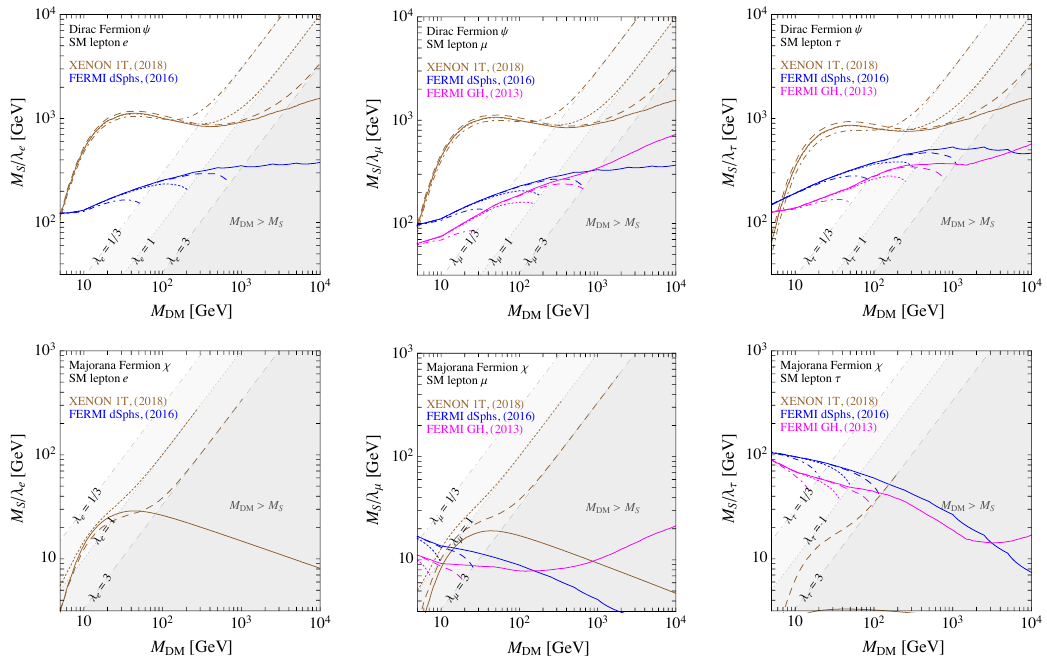
Figure 7 . Constraints on the UV models for Dirac (upper panels) and Majorana DM (lower panels), for couplings to e; (cid:22) and (cid:28) . In grey is shown the excluded region of parameter space where M DM > m S , which depends on (cid:21) i due to the choice of the y-axis. Regions below the brown lines are excluded by DD constraints from XENON1T, while the blue (magenta) lines denote the bounds from ID, coming from FERMI observations of dwarf Spheroidal galaxies (Galactic Halo). Constraints shown as solid lines arise from considering just the e(cid:11)ective operators, and only depend on the combination m S =(cid:21) i . The full (cid:12)xed order calculation also depends on (cid:21) i and m S separately, and we show the resulting constraints for (cid:21) i = 1 = 3 (dot-dashed), (cid:21) i = 1 (dotted) and (cid:21) i = 3